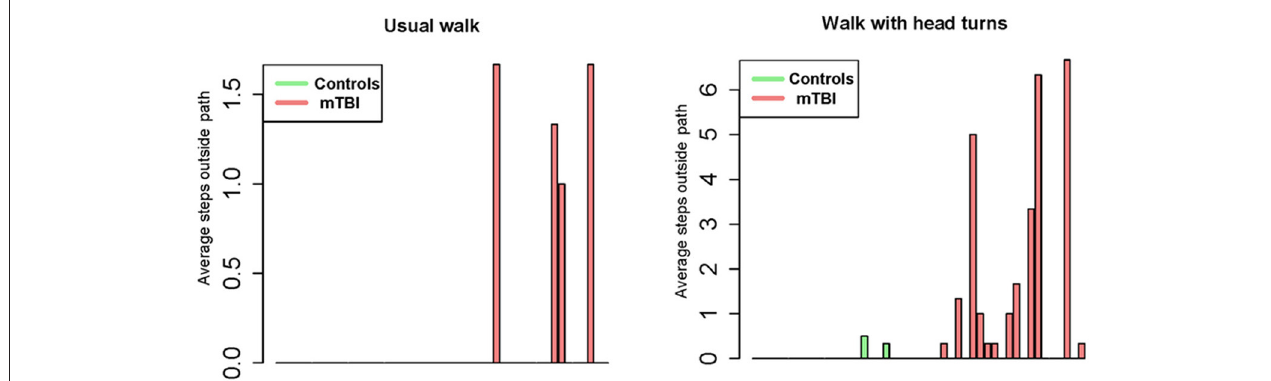
FIGURE 4 | Bar graph representation of steps taken outside the 12-inch pathway during usual walk and walking with head turns between controls and participants with mTBI.